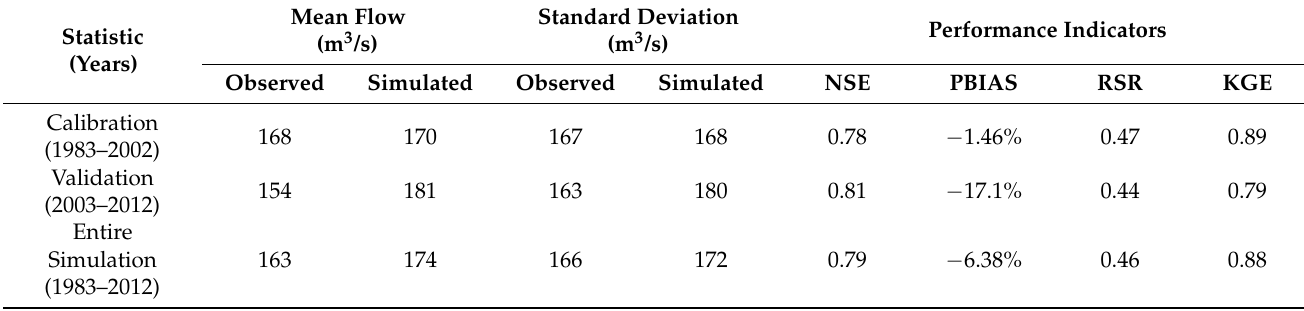
Figure 6. Scattered plots for daily flow in ( a ) calibration and; ( b ) validation; cumulative volume balance in the ( c ) calibration period; and the ( d ) validation period. 3.3. Additional Validation of SWAT at Supplementary Stations Previous studies, e.g., [25,85] have used multi-site approach to calibrate the SWAT model. In the current study, the model is calibrated at a single point and validated at three supplementary points upstream and downstream of Arughat: (i) intake site of Budhigan- daki KA (BG KA), (ii) intake site of Budhigandaki KHA (BG KHA) and (iii) 1200 MW Budhigandaki Hydroelectric Project (BGHEP) dam site (see Figure 1). It is to be noted that the study team carried out rigorous discharge measurements and prepared rating curves at these three locations during 2009–2010 (BG KA and BG KHA) and 2013–2014 (BGHEP damsite) which has been used for the additional validation. The results of the validation